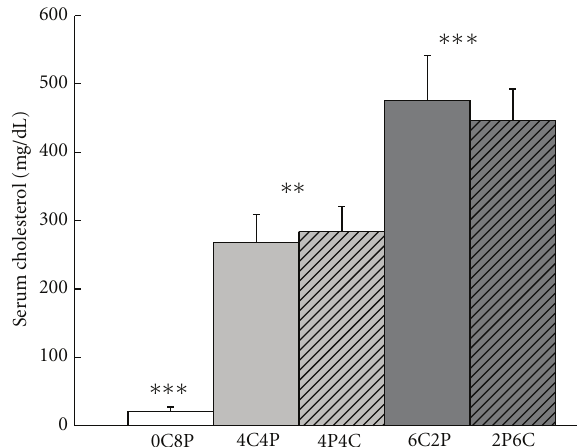
Figure 5: Mean total serum cholesterol levels at euthanasia for rabbits in the 6CP2, 2PC6, 4C4P, 4P4C, and 0C8P groups. ∗∗ P < . 01, ∗∗∗ P < . 001.